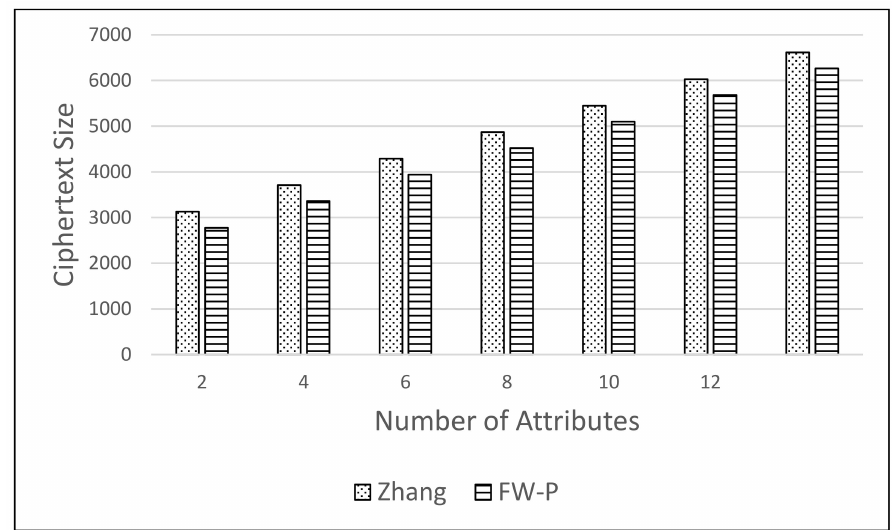
Figure 11. Storage cost of